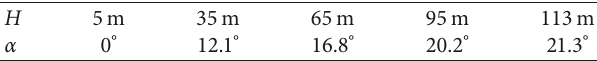
Figure 4: Configuration of the main cable-inspection vehicle coupled system (unit: mm). Table 4: The relation between H and α